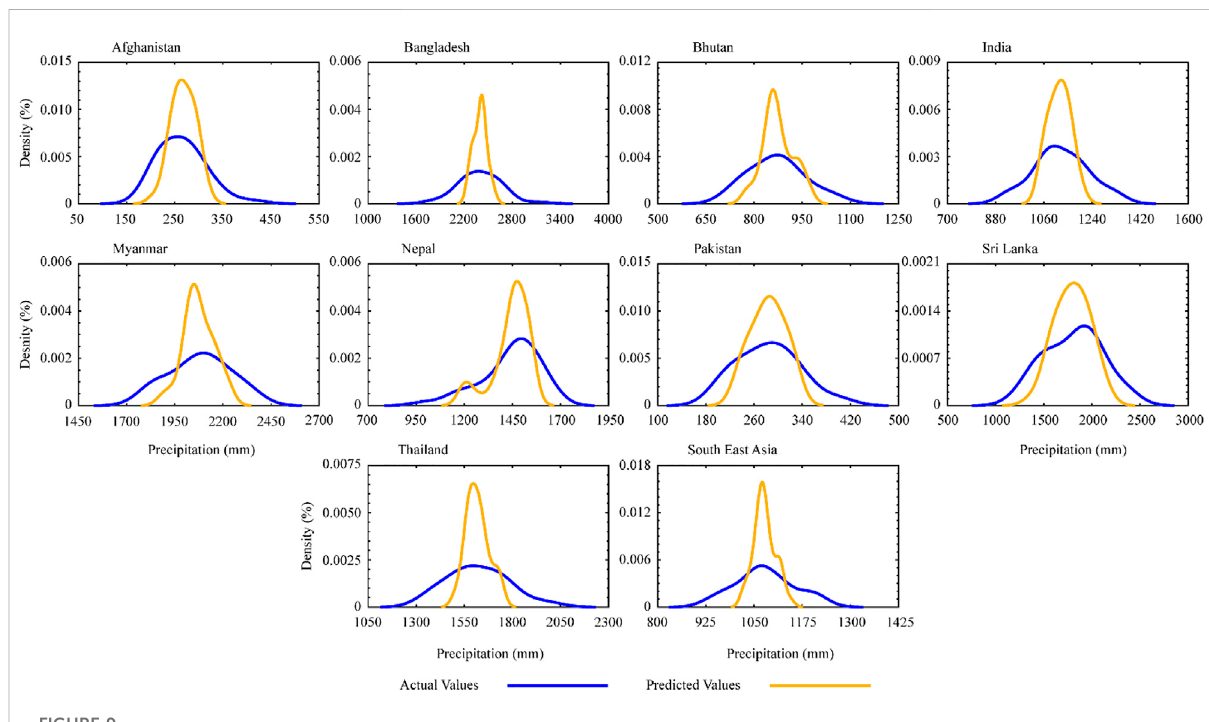
FIGURE 9 Probability distribution function of annual actual and predicted precipitation values during 1981 –